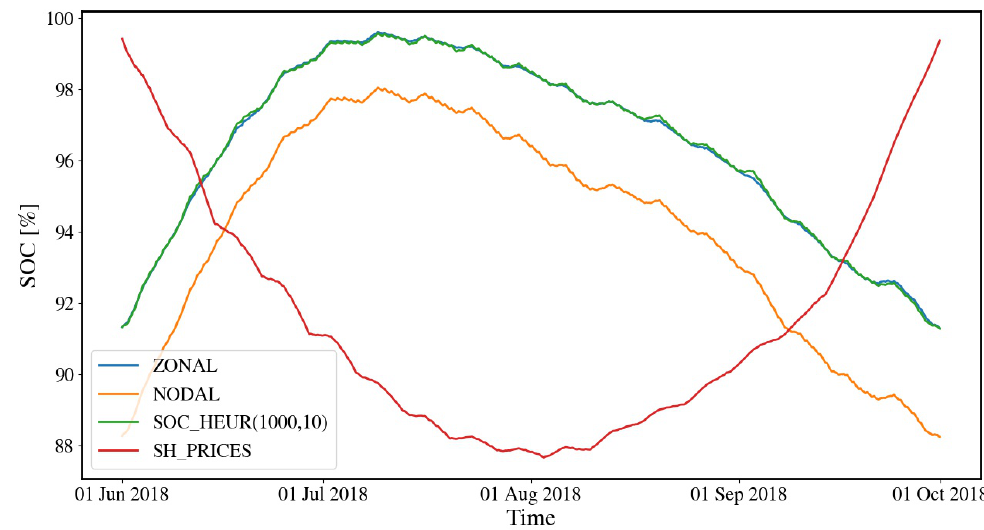
Figure 4. Aggregated SOC profiles in % for the short-time horizon benchmark with transmission capacity factor β = 0.5. Zonal input profile from Stage 1 (blue), full nodal benchmark case NODAL (orange), and penalty factor combination SOC _ HEUR ( 1000,10 ) (green) and SH _ PRICES